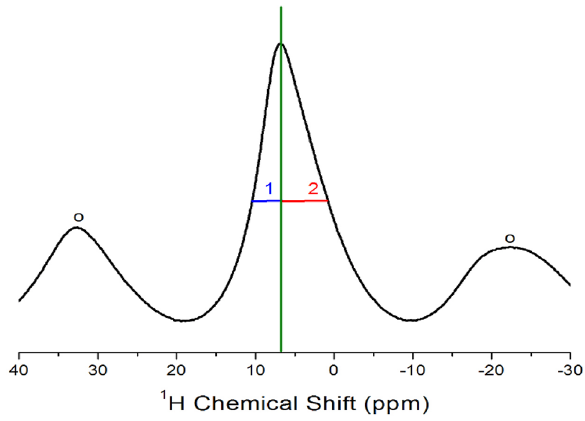
Figure 5. MAS 1 H NMR line shapes of [NH 3 (CH 2 ) 3 NH 3 ]ZnBr 4 at 300 K.